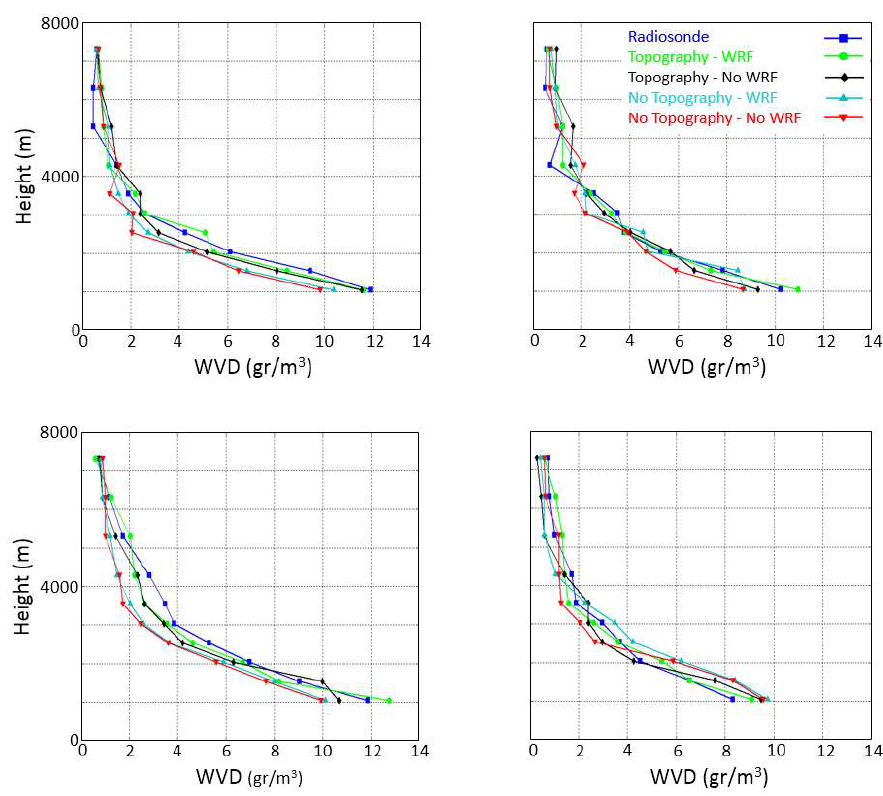
Figure 10. An example of the obtained WVD field .